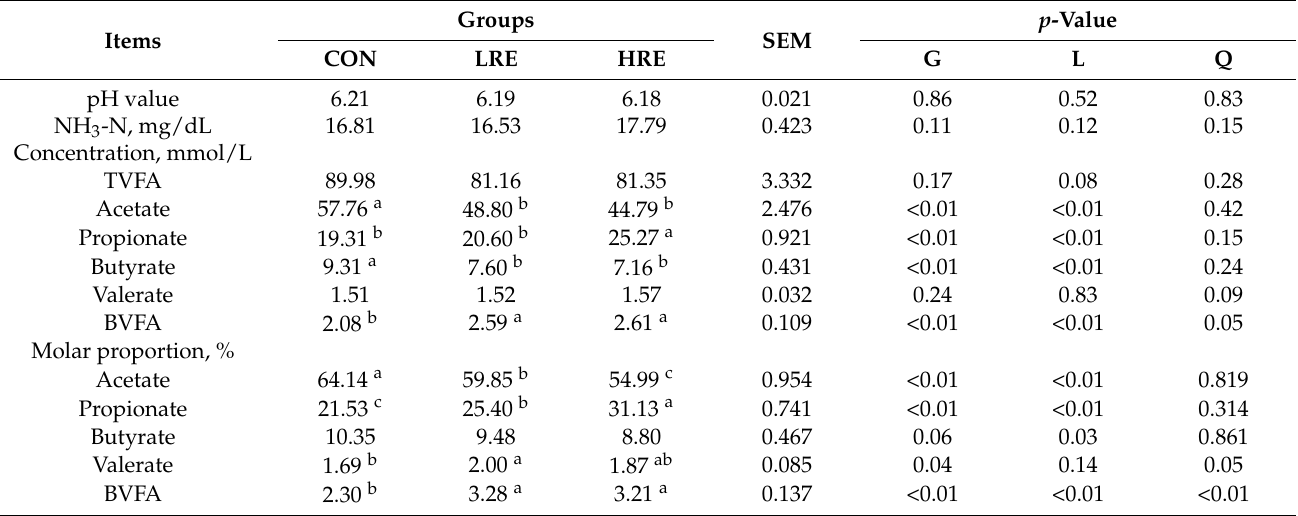
Table 4. Effects of different doses of rosemary extract on in vitro fermentation parameters.